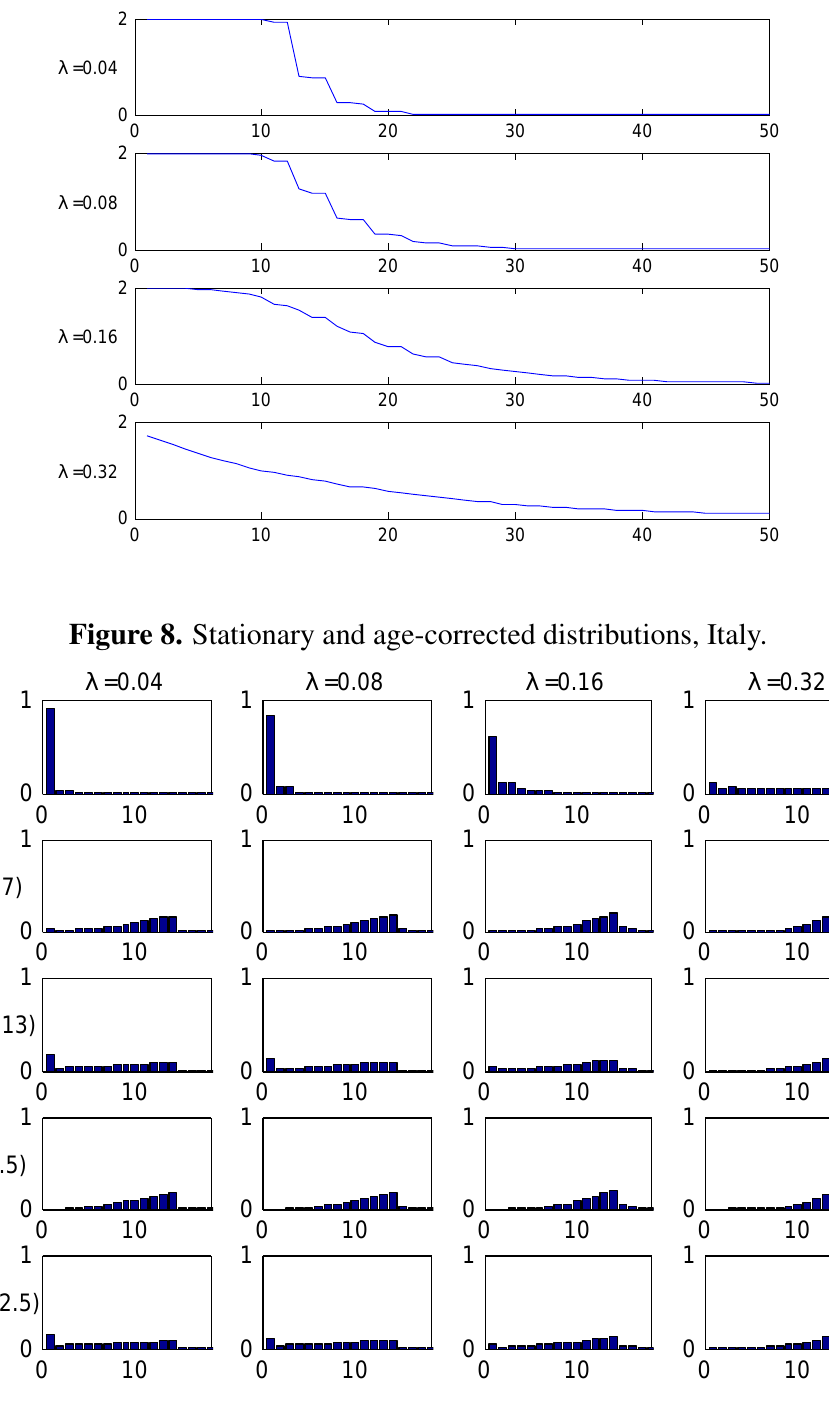
Figure 7. T.v. convergence rate, Italy.